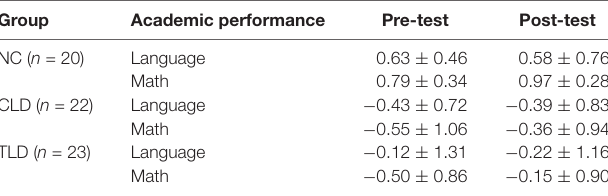
TABLE 3 | The academic performance (Z) of each group in pre- and post-test